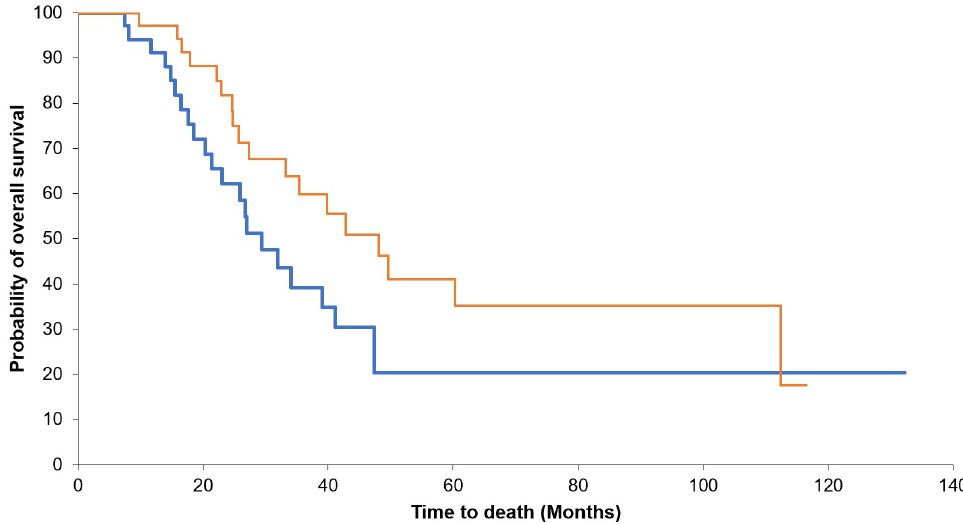
Fig 5. Subgroup analysis: Except for the early recurrence group. Overall survival (OS) according to the change in the skeletal muscle mass ratio (SMR) at 24 weeks after surgery. In the lower group (blue line), the SMR at 24 weeks after resection was related to shorter overall survival than that in the higher group (red line), but this was not statistically significant ( P = 0.07).